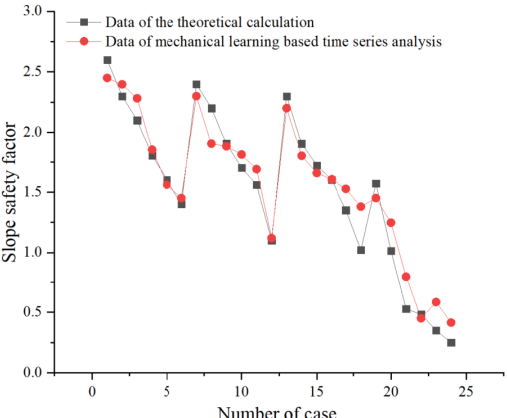
Figure 12. Mechanical learning-based time series analysis to slope stability prediction.